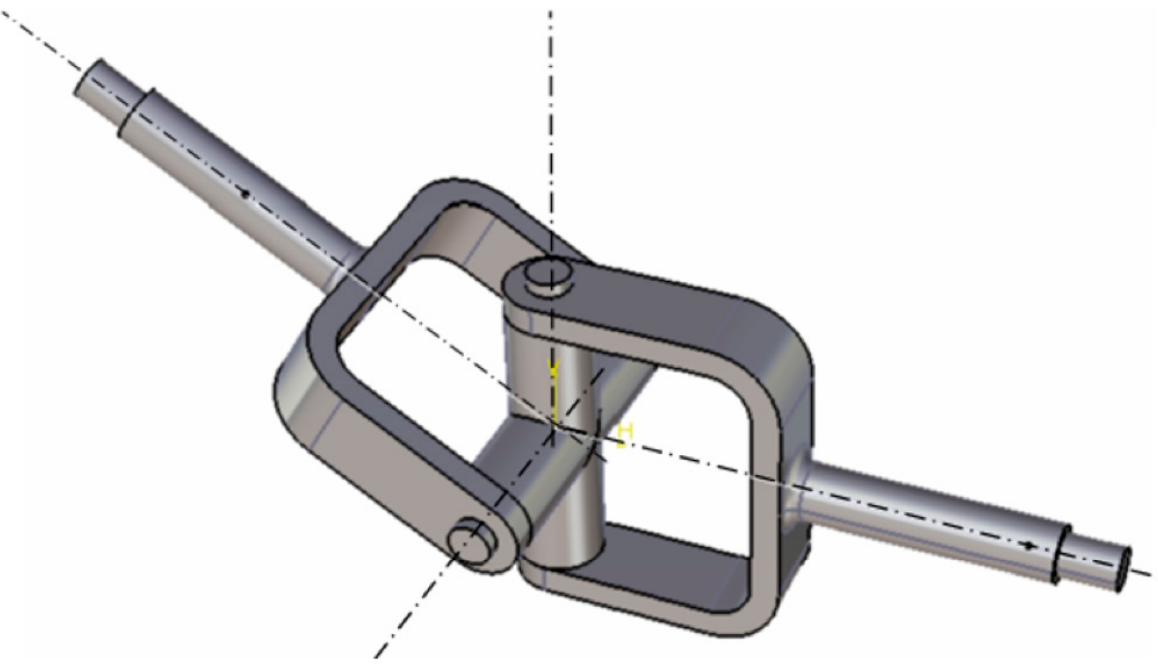
Figure 1. Cardan